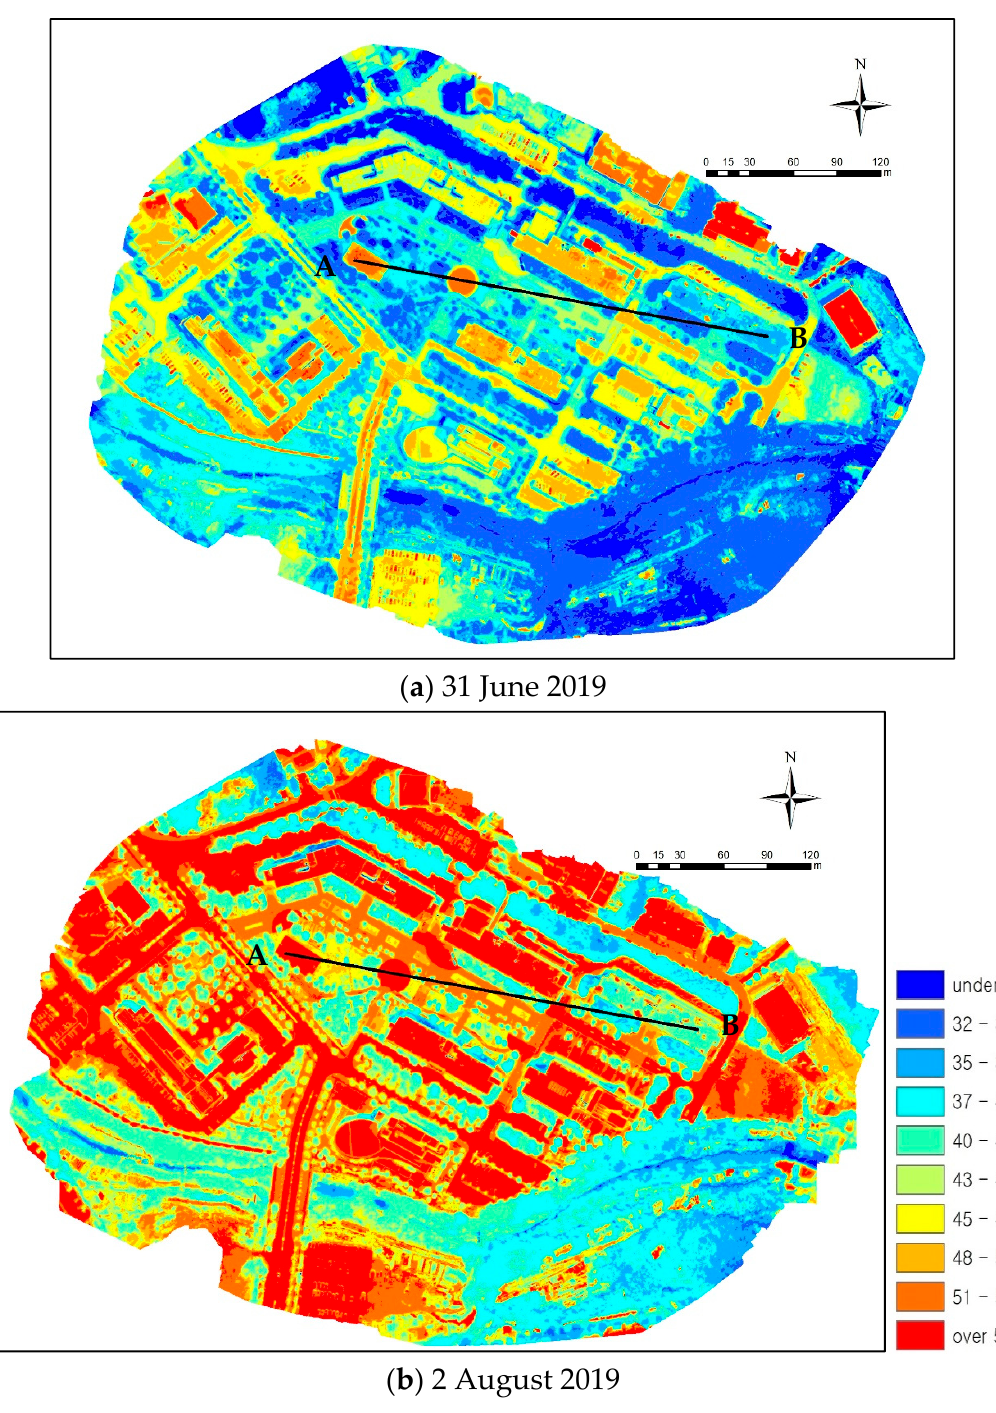
Figure 4. LST distribution in UAV TIR images showing the location of the A–B profile with a black line: ( a ) 31 June 2019; ( b ) 2 August 2019.